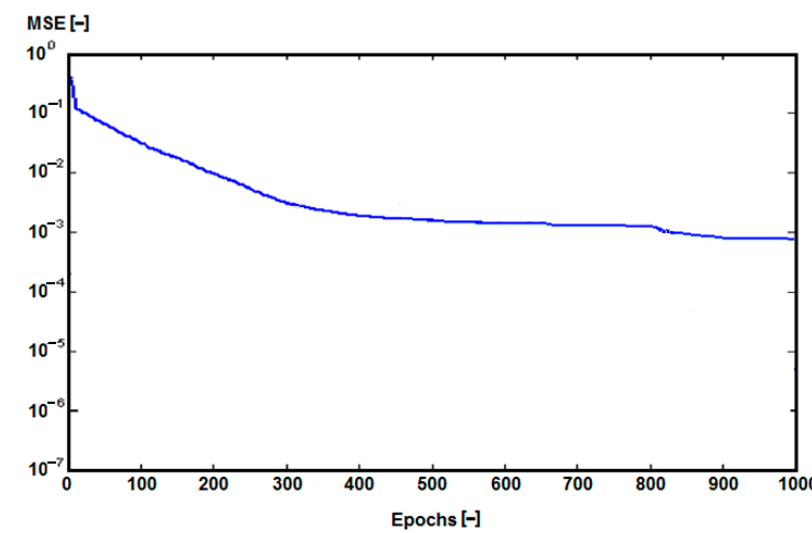
Figure 8. Values of MSE during learning for ANN (MLP 8-10-3).